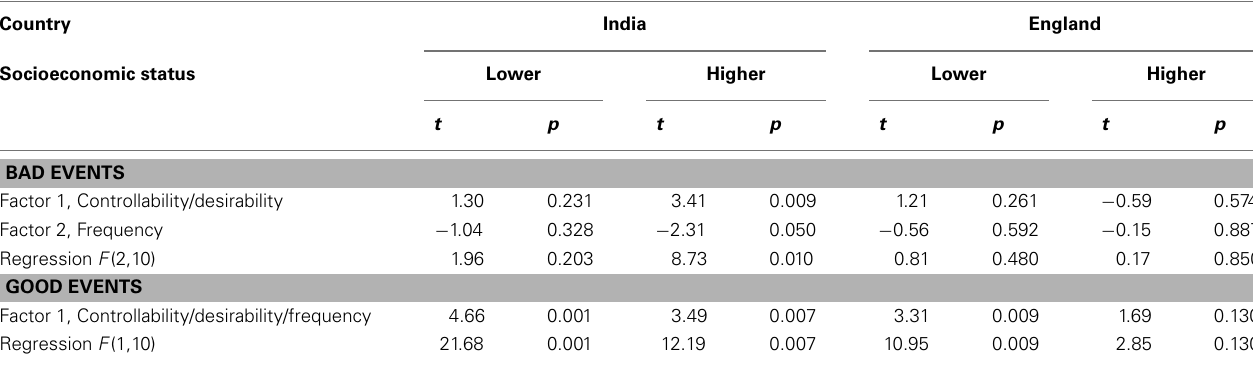
Table 6 | Regression coefficients showing the relationship of event controllability, desirability, and frequency to comparative